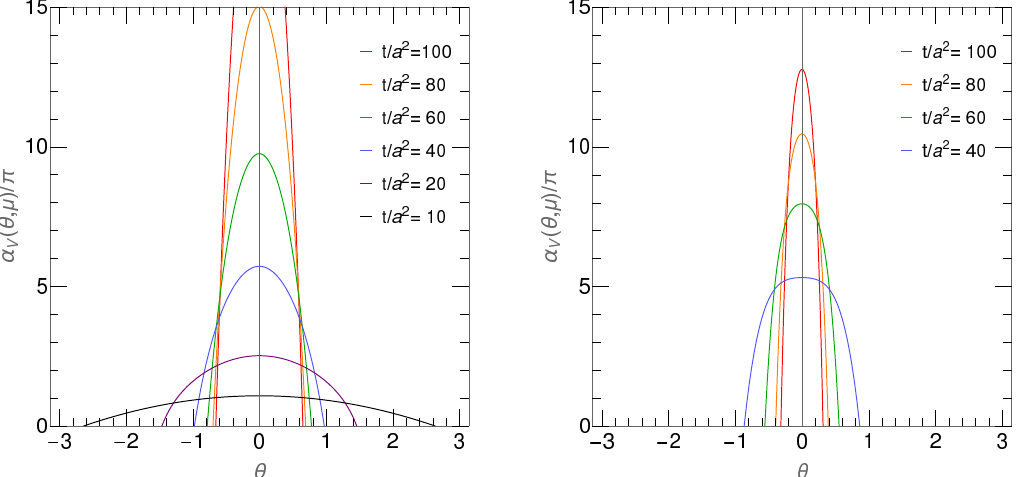
( θ , µ ) as a function of θ on the 16 4 (left) and Figure 5: The running coupling α V the 32 4 lattice (right) for flow times ranging from t / a 2 = 10 (bottom) to 100 (top). (cid:39) 0.729 α Note that α . V GF